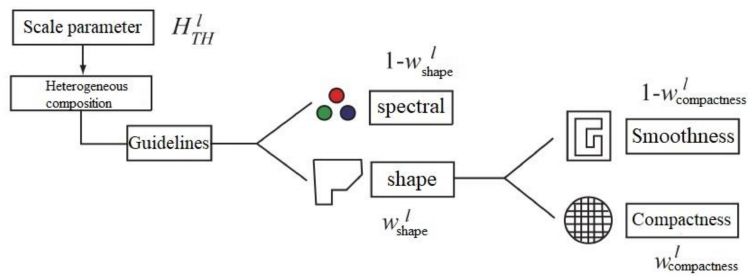
Figure 2. The concept of multiresolution segmentation (revised from the Definiens Developer 7 reference book).